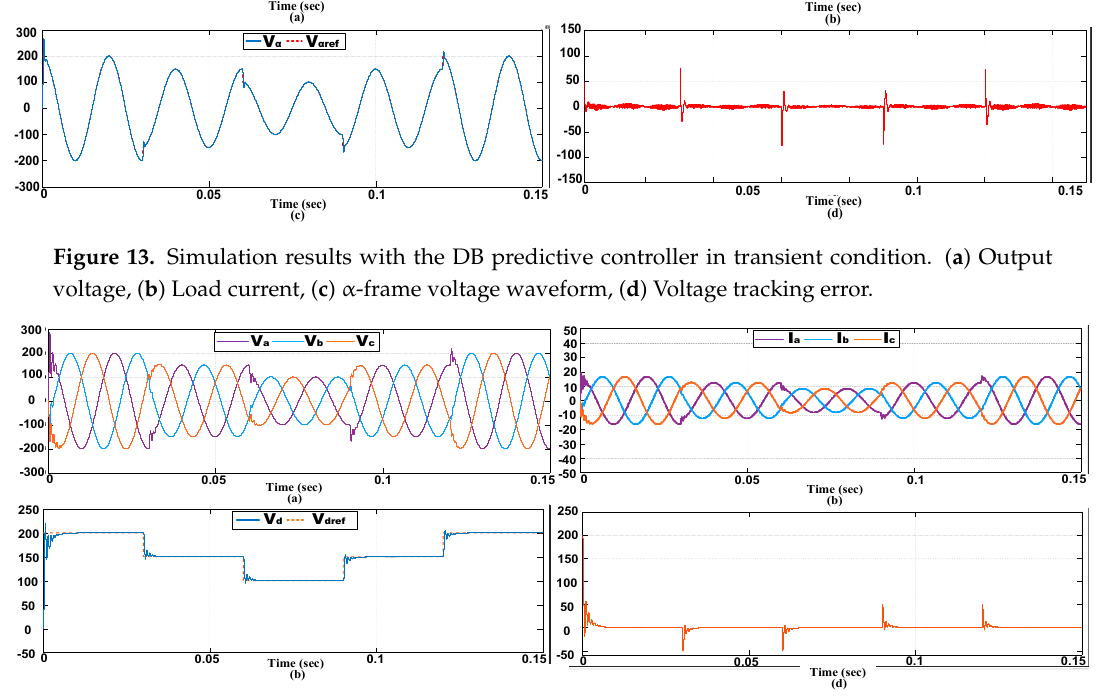
Figure 14. Simulation results with the PI controller in transient condition. ( a ) Output voltage, ( b ) Load current, ( c ) d-frame voltage waveform, ( d ) Voltage tracking error.